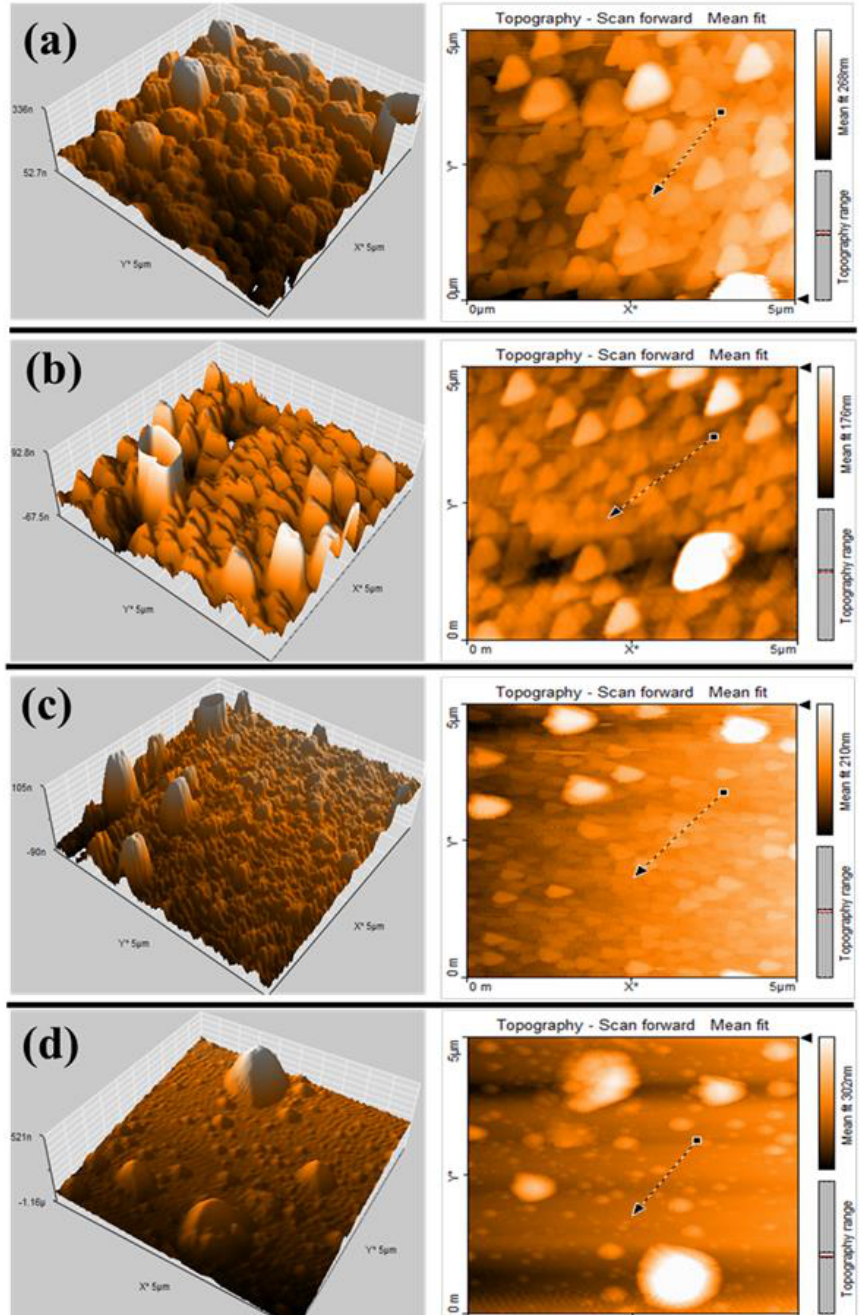
Figure 3. 2D and 3D atomic force microscopy (AFM) images of the Y/Sialon thin films prepared by PLD at: ( a ) RT; ( b ) 100 °C; ( c ) 300 °C; ( d ) 500 °C.